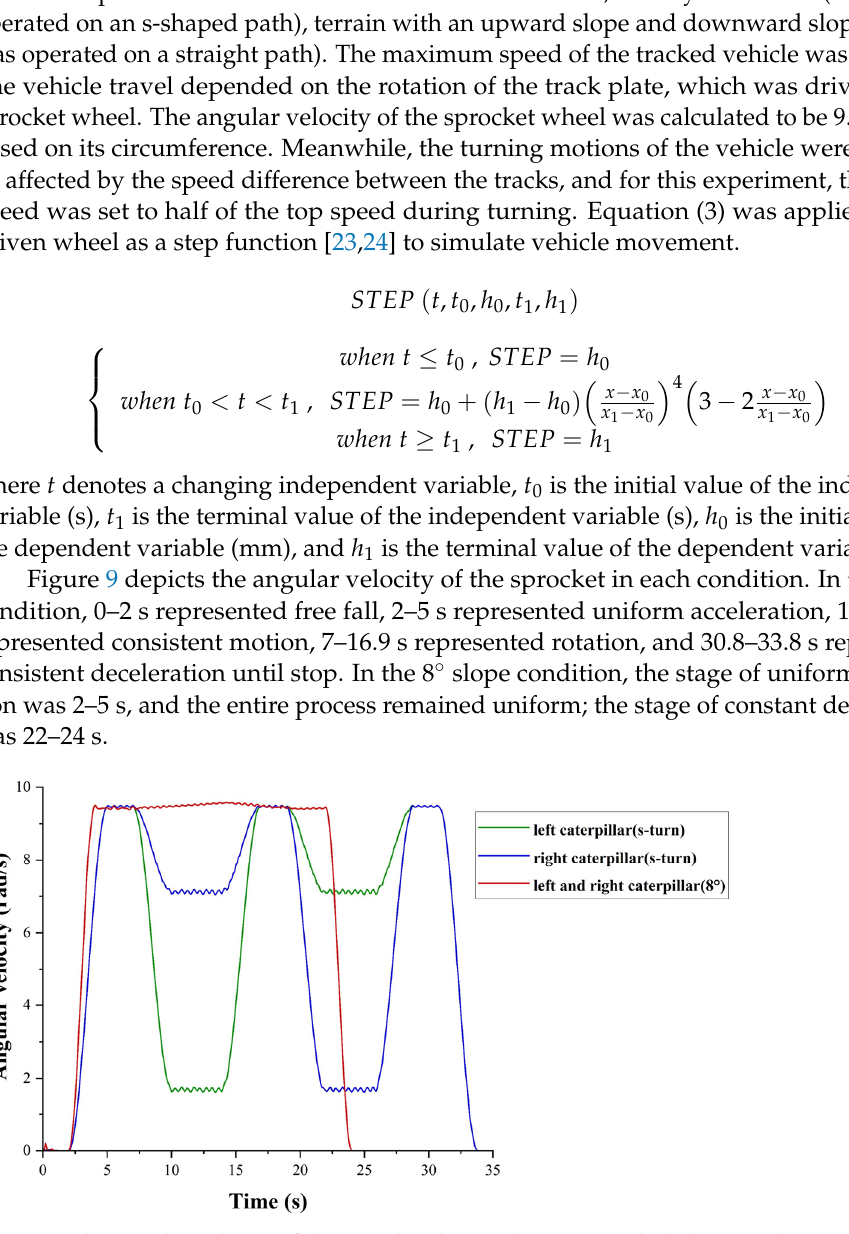
Figure 9. The angular velocity of the sprocket during the s-turn and 8 ° slope conditions.